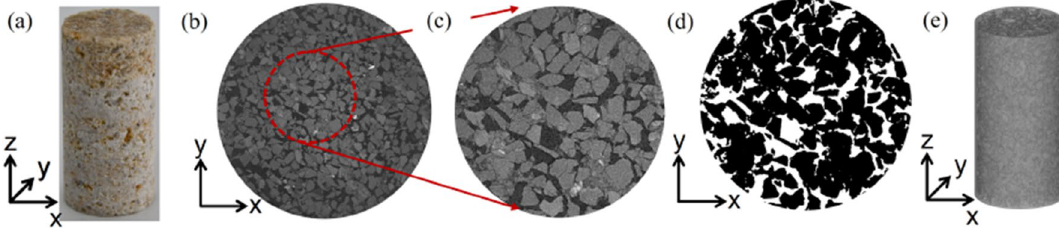
Fig. 2 Construction of digital porous sandstone model. a Natural sandstone sample; b – d Extraction of discontinuous pores in sandstone; e Digi- tal model